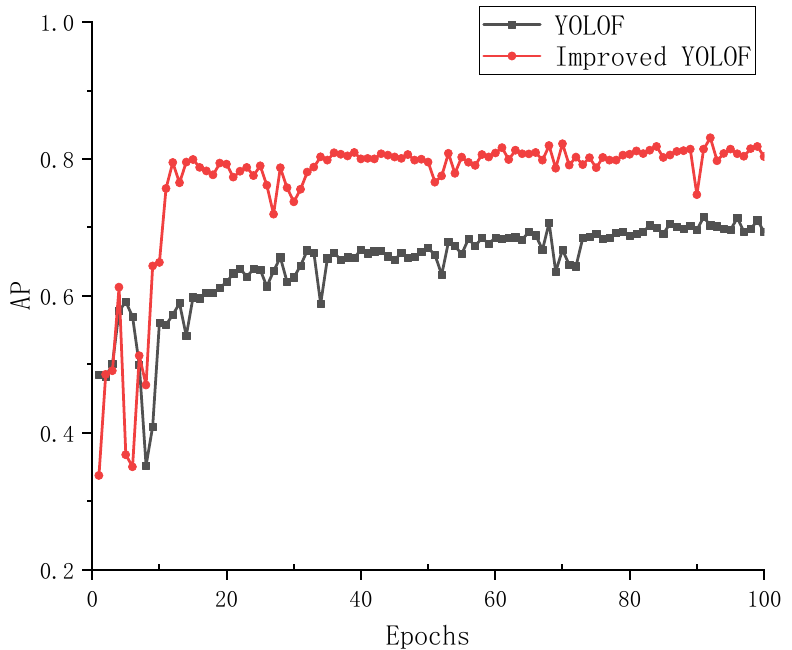
Figure 4. Ap of the detection networks.